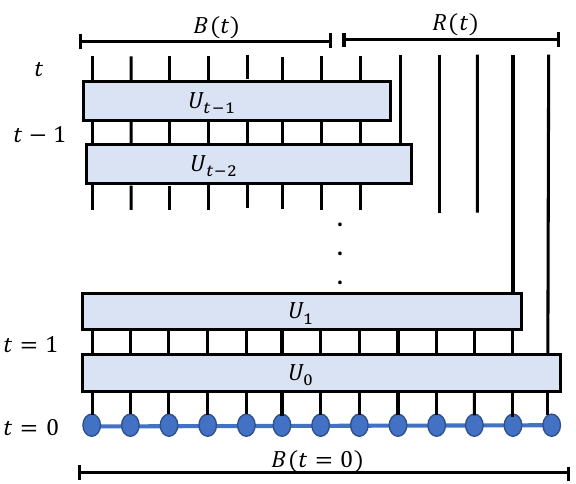
Figure 5 . Time-evolution of the evaporating black hole. In the first half of each time-step, a Haar-random matrix from U ( q k − t ) is applied within B ( t ) , and in the second half, a site is taken out of B and put in R to give B ( t + 1) and R ( t + 1)